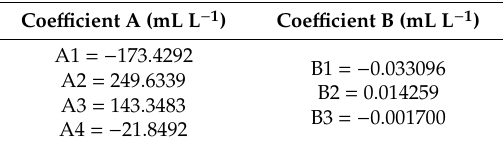
Table A1. Coe ffi cients A and B for calculating the dissolved oxygen